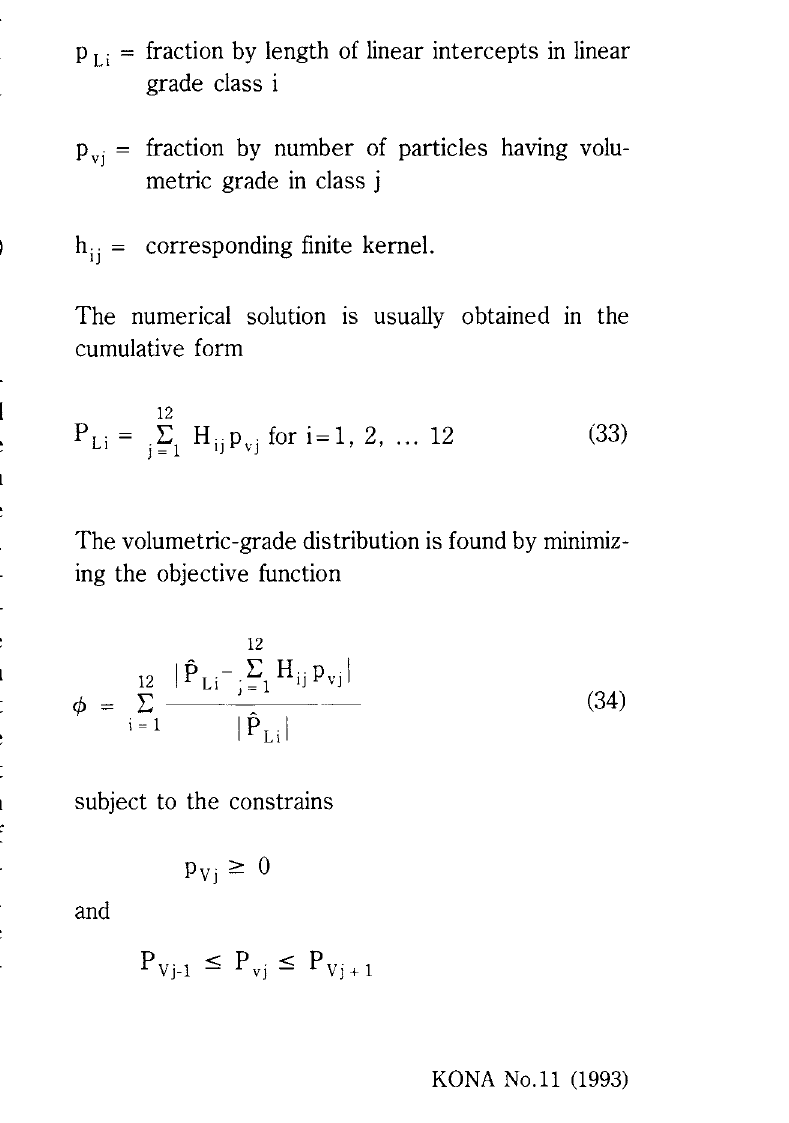
Fig.8 A guard frame can be used to eliminate the frame error when doing linear-intercept analysis. Linear intercepts shown as thin lines are rejected.